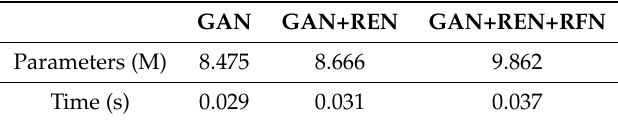
Table 2. Parameters and time overhead